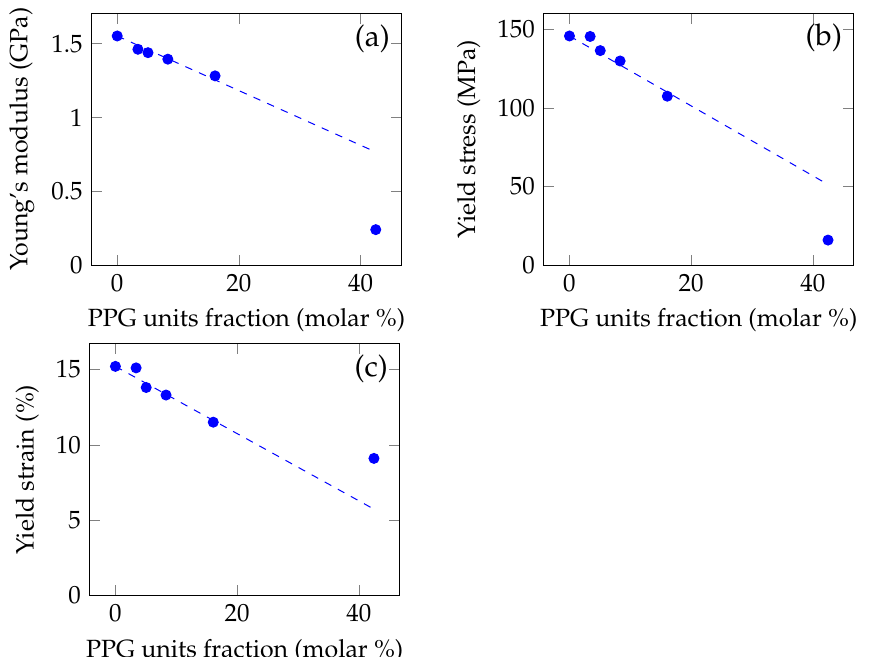
Figure 5. The results of the uniaxial compression testing illustrate the effect of the poly(propylene glycol) content on the mechanical properties. M n of PPG is 446. ( a ) The dependence of the elasticity modulus on the content of polypropylene glycol. ( b ) The dependence of the yield stress on the content of PPG. ( c ) The dependence of the yield strain on the content of PPG. The dependencies show that the modulus, the yield stress and strain monotonously decrease with increasing PPG molar fraction, and this relation is linear in the region of the moderate (up to 17%) fractions of the PPG